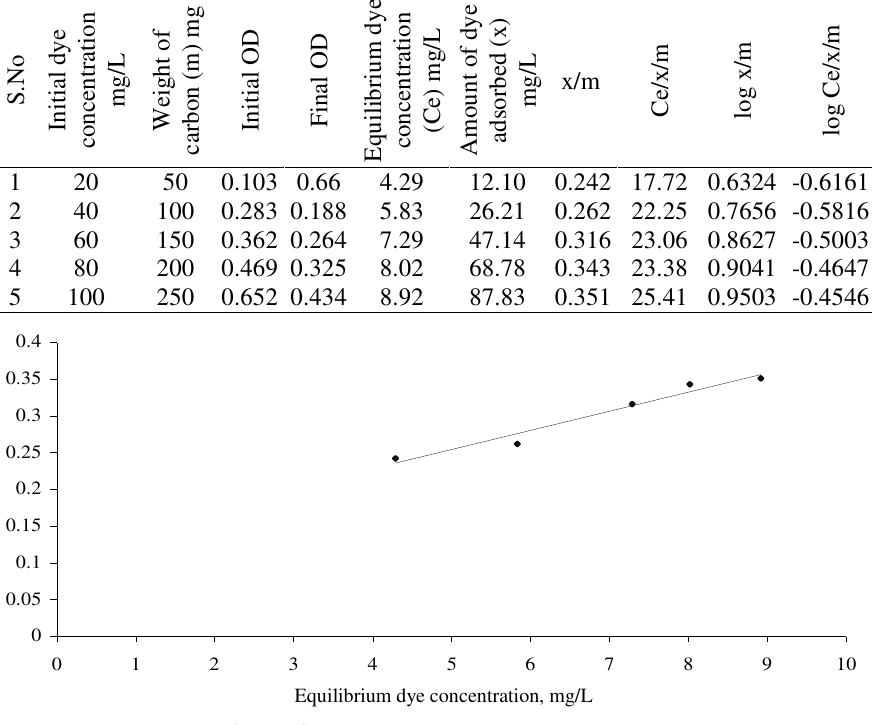
Figure 4. Equilibrium adsorption of